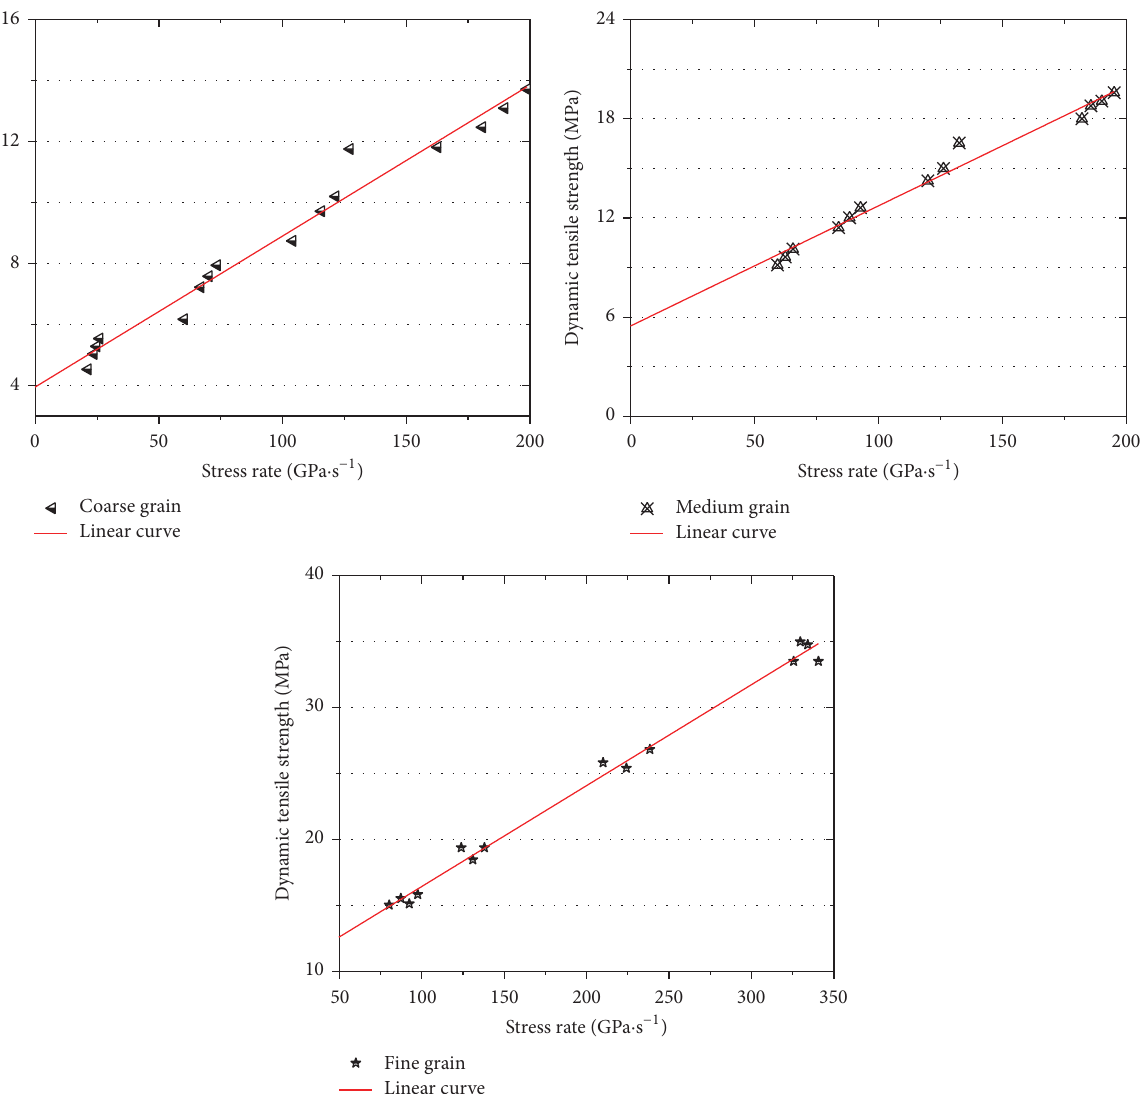
Figure 14: The dynamic strength versus stress rates for sandstones with different grain